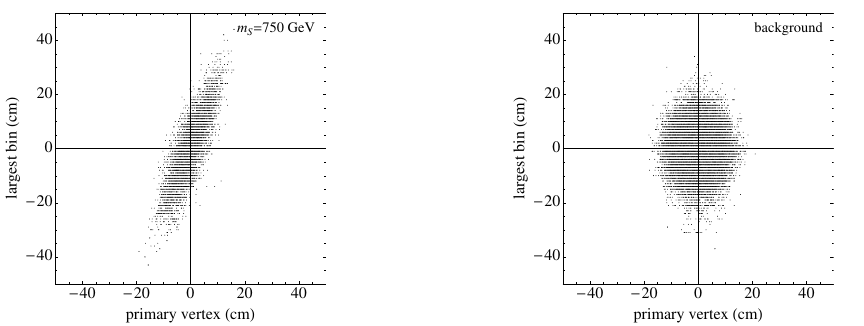
Figure 14. X max discriminant.